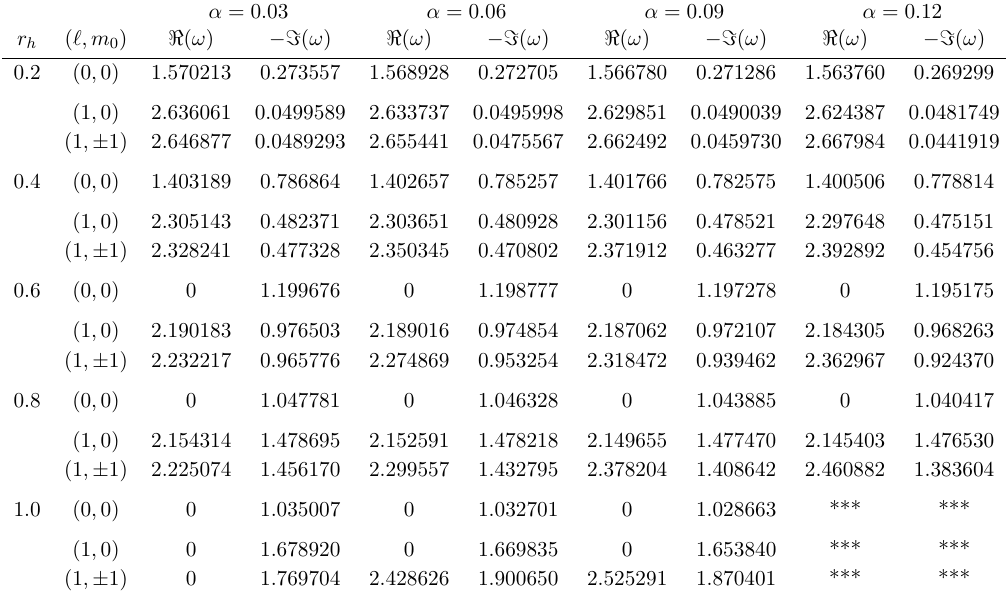
Table 4 . Quasinormal modes of the ARNAdS black holes with Λ = − 3 and Q = 0 . 7